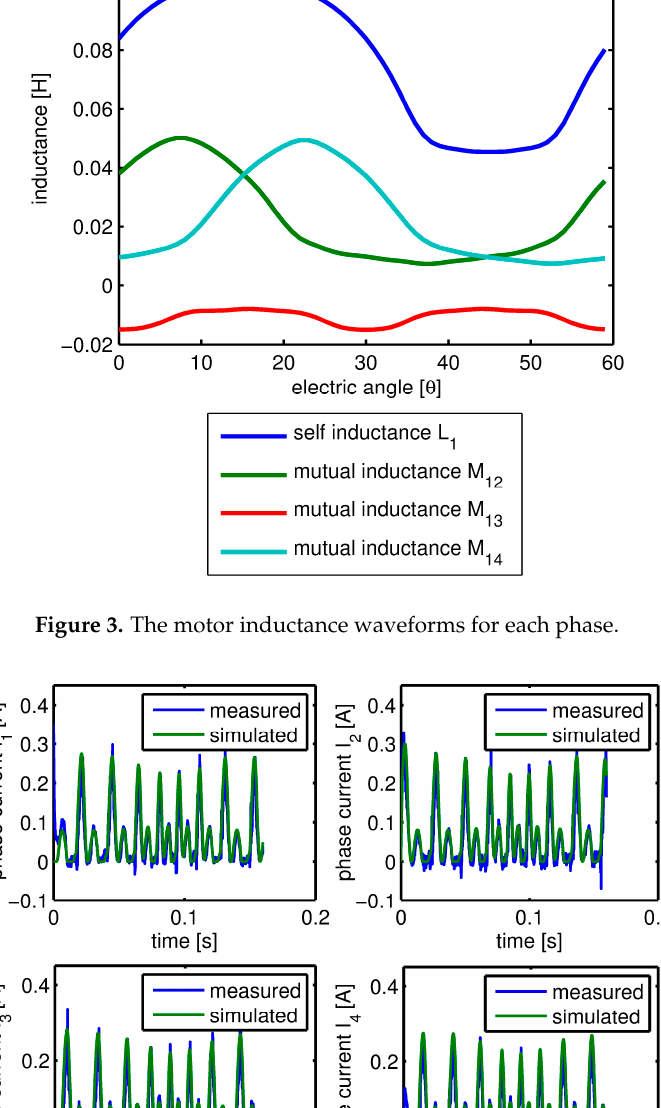
Energies 2017 , 10 , 799 8 of 14 Figure 2. The motor phase windings and the unipolar drive circuit. Table 1. Motor parameters. Outer diameter of stator